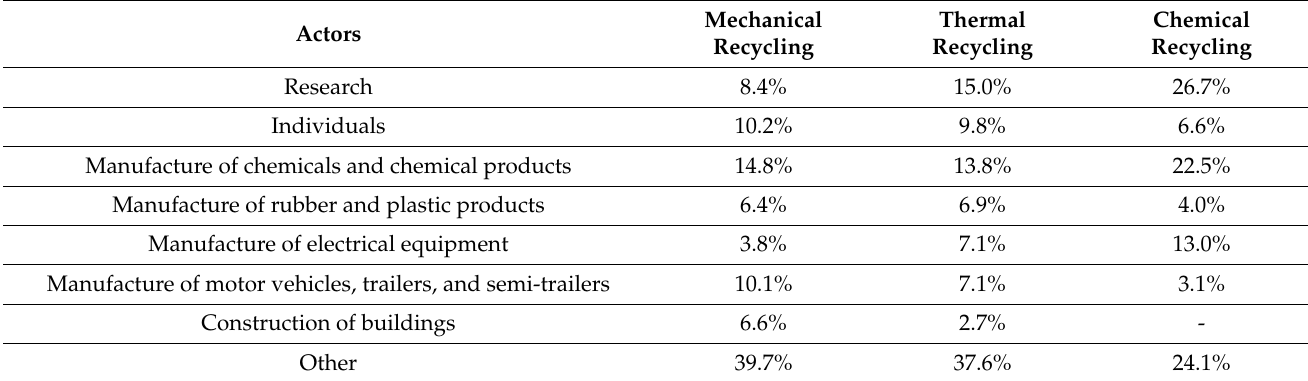
Table 4. Patent holdings by recycling macro-category and assignee